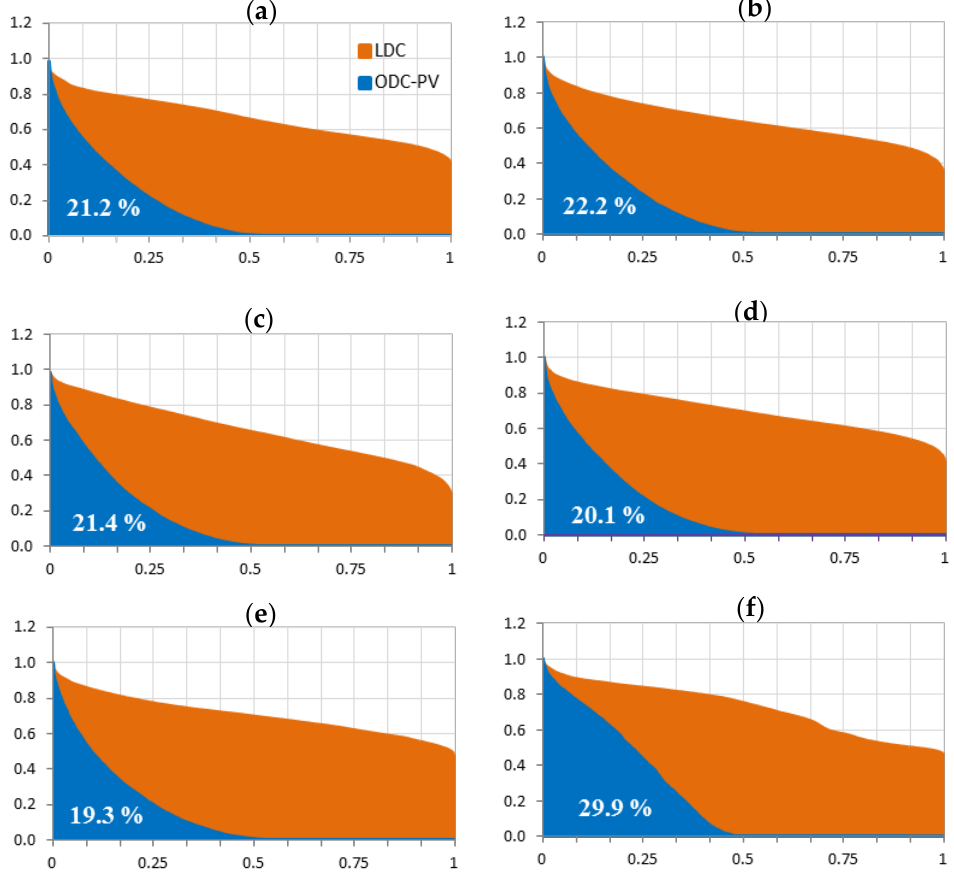
Figure 9. Limit of the CDPV for six european large electricity grids: ( a ) Amprion (Germany), ( b ) Tennet (Germany), ( c ) Transnet (Germany), ( d ) 50 Hertz (Germany), ( e ) Elia (Belgium) and ( f ) REE-Tenerife (Spain, Canary Islands). Table 2. CD PV estimation for several European large electricity grids.